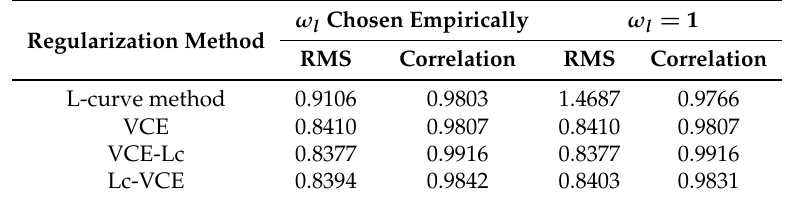
Table 4. Results of Study Case F: the RMS values (unit [m 2 /s 2 ]) as well as the correlations for each